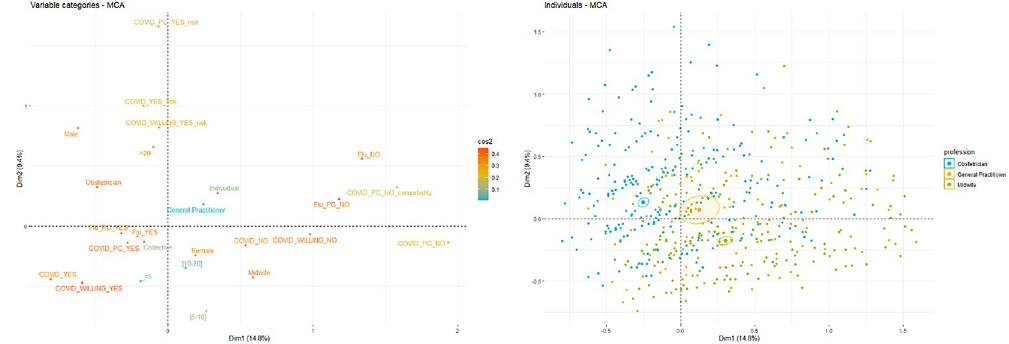
Fig 1. Multiple correspondence analysis map (projections on the first two dimensions) for prenatal caregiver’s answers and the perceptions of the SARS-Cov-2 vaccine for variable variables (left) and individual (right). Active variables: gender (woman and man); profession (obstetrician, general practitioner, midwife); experience ( � 5,] 5–10],] 10–15] or � 15); modalities of exercise (collective or individual); practitioners’ flu vaccine (yes or no); pregnant women flu vaccine (yes or no); practitioners’ SARS-CoV-2 vaccination for themselves (no, no because I do not have risk factors, yes or yes because I have risk factors), pregnant women’s SARS-CoV-2 vaccination (yes, yes only for pregnant women with risk factors) and women willing to be pregnant SARS-CoV-2 vaccination (yes, yes only for pregnant women with risk factors). The categories defining the horizontal axis, which explain 15% of the variability, are refusing to be vaccinated and refusing to be vaccinated under the argument of lack of comorbidity (towards the right of the map) and at the opposite the agreement to vaccinate pregnant women and women willing to be pregnant (towards the left). The vertical axis accounts for 9% of the variability of the system, being the one that best discriminates between the categories of the variable ‘profession’, with obstetricians and gynaecologists and midwives having a negative association (angle value close to 180 degrees).